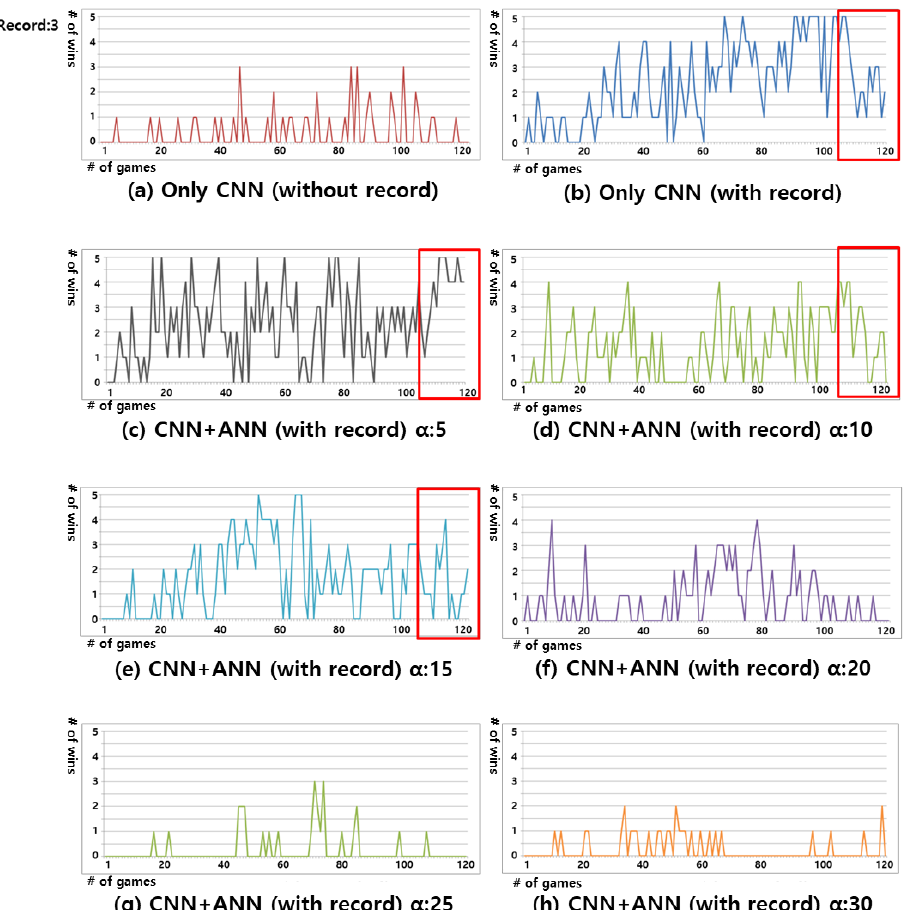
Figure 7. Result of Win rate when Record count was three. Each graph y -axis refers to the number of